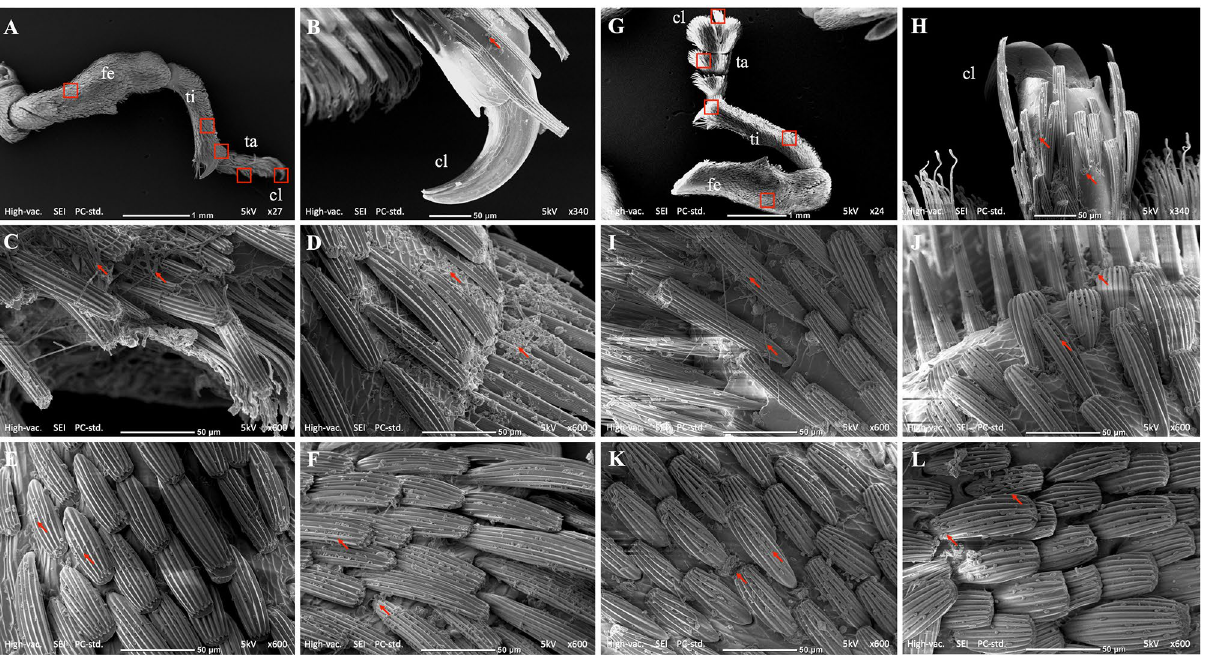
Figure 6. ( A , G ) Lateral view of the foreleg showing claws (cl), tarsus (ta), tibia (ti) and femur (fe). Fungal conidia attached and/or germinated on ( B , H ) claws, ( C , I ) tarsus, ( D , J ) tibial comb, ( E , K ) scales on the tibia and ( F , L ) scales on the femur. The red arrows point at the conidia and/or germinated conidia of B27 ( B – F ) and ECS1 ( H – L ); the red boxes in image A and G indicate the leg parts shown at higher magnification in images B – F and H – L , respectively. As there were numerous conidia either attached to, or germinated on the weevil, the arrows are used to indicate examples.